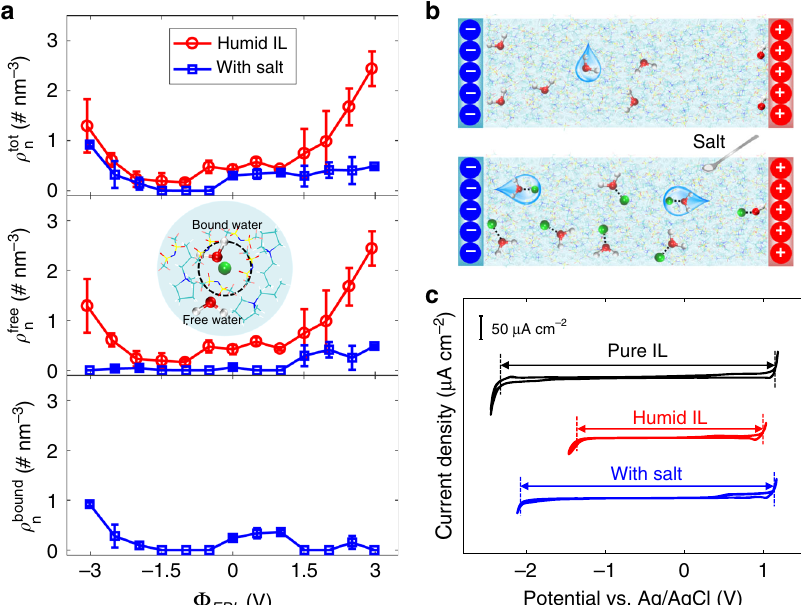
Fig. 2 Effect of adding salt on the interfacial water and electrochemical window of electrolytes. a Electrosorption of water from humid 1-methyl-1- propylpyrrolidinium bis(tri fl uoromethylsulfonyl)imide ([Pyr 13 ][TFSI]) with/without adding salt. The top, middle and bottom panels are, respectively, the number densities of the total ( ρ tot n ), free ( ρ free n ) and Li + -bound water ( ρ bound n ) in the interfacial region. b Schematic of the effect of adding salt on water electrosorption. c Cyclic voltammograms of HOPG in pure [Pyr 13 ][TFSI] (black line), humid [Pyr 13 ][TFSI] (red line), and salt-in-humid [Pyr 13 ][TFSI] electrolyte (the molar salt – water ratio = 1:1, blue line). Scan rate: 100 mV s − 1 . Water contents for humid [Pyr 13 ][TFSI] are 4392 and 4474 ppm for MD simulation and cyclic voltammetry experiments,